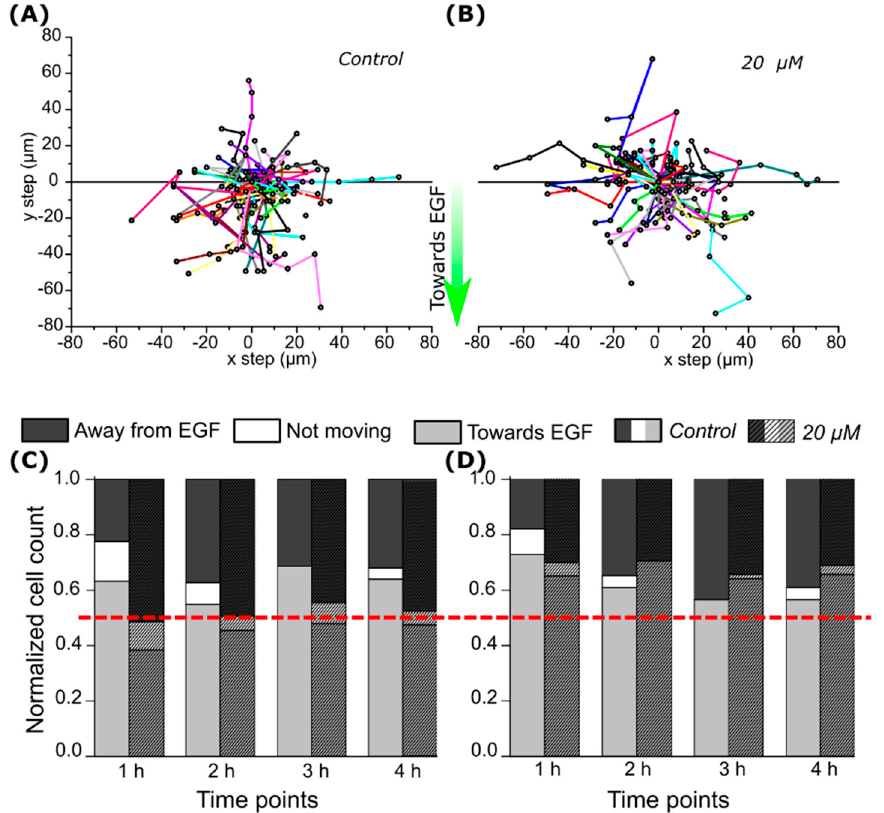
Figure 6. MDA-MB-231 cell chemotaxis . MDA-MB-231 cell migration paths in the control group ( A ) and in a group treated with 20 µM of VD11-4-2 ( B ). Paths towards negative y values show migration towards higher EGF concentrations. Normalized cell count of cells under hypoxia ( C ) and normoxia ( D ) migration towards or away from higher EGF concentrations.